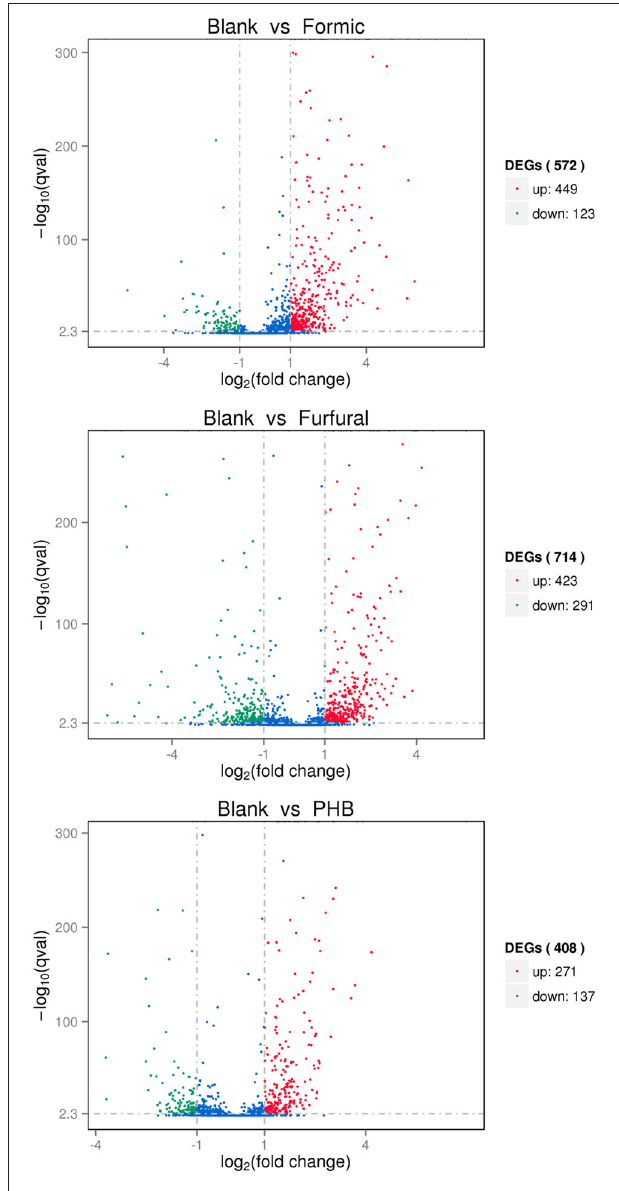
FIGURE 1 | Volcano plot displaying differential expressed genes between the blank sample and the inhibitor treated samples. The y -axis corresponds to the mean expression value of the log 10 ( p -value) and the x -axis displays the log 2 (Fold-change) value. The red dots represent the upregulated expressed genes, the green dots represent the downregulated expressed genes, and the blue dots represent the transcripts whose expression levels did not reach statistical significance between two